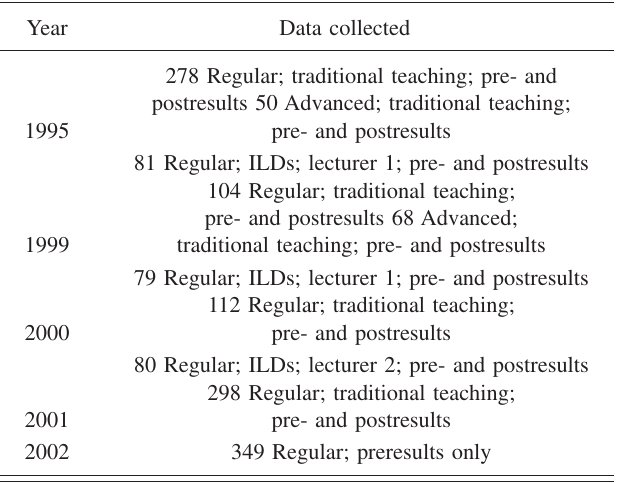
TABLE I. Various sources of the data used in the analysis of Project I.